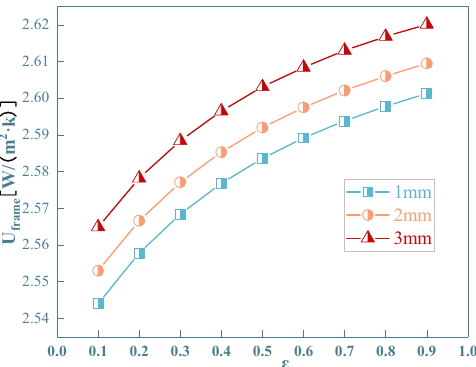
Figure 9. Effect of surface emissivity of RIP on U-factor of window frame.